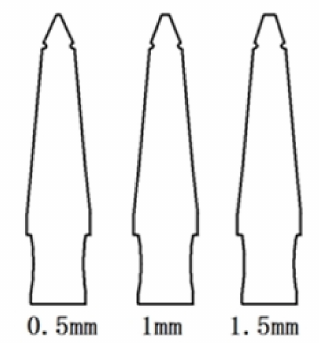
Figure 18. Computational model of three di ff erent cavitation nose diameters.